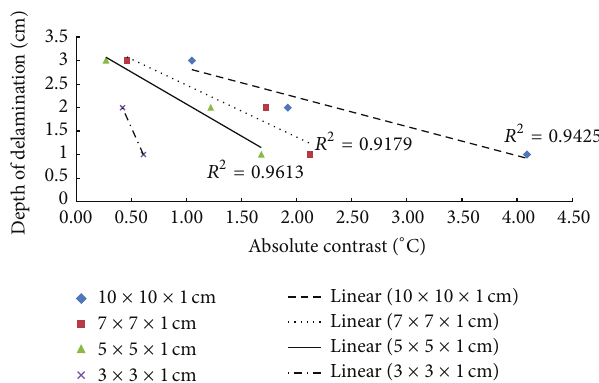
Figure 14: Depth versus the absolute contrast for the 20-minute heating